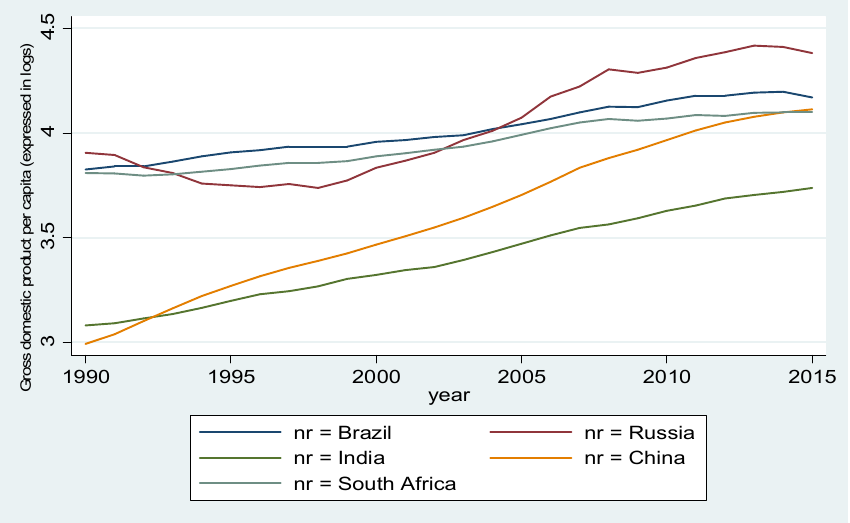
Figure 2. Panel data distribution of income per capita. Source: Authors’ elaboration based on World Development Indicators (2021).